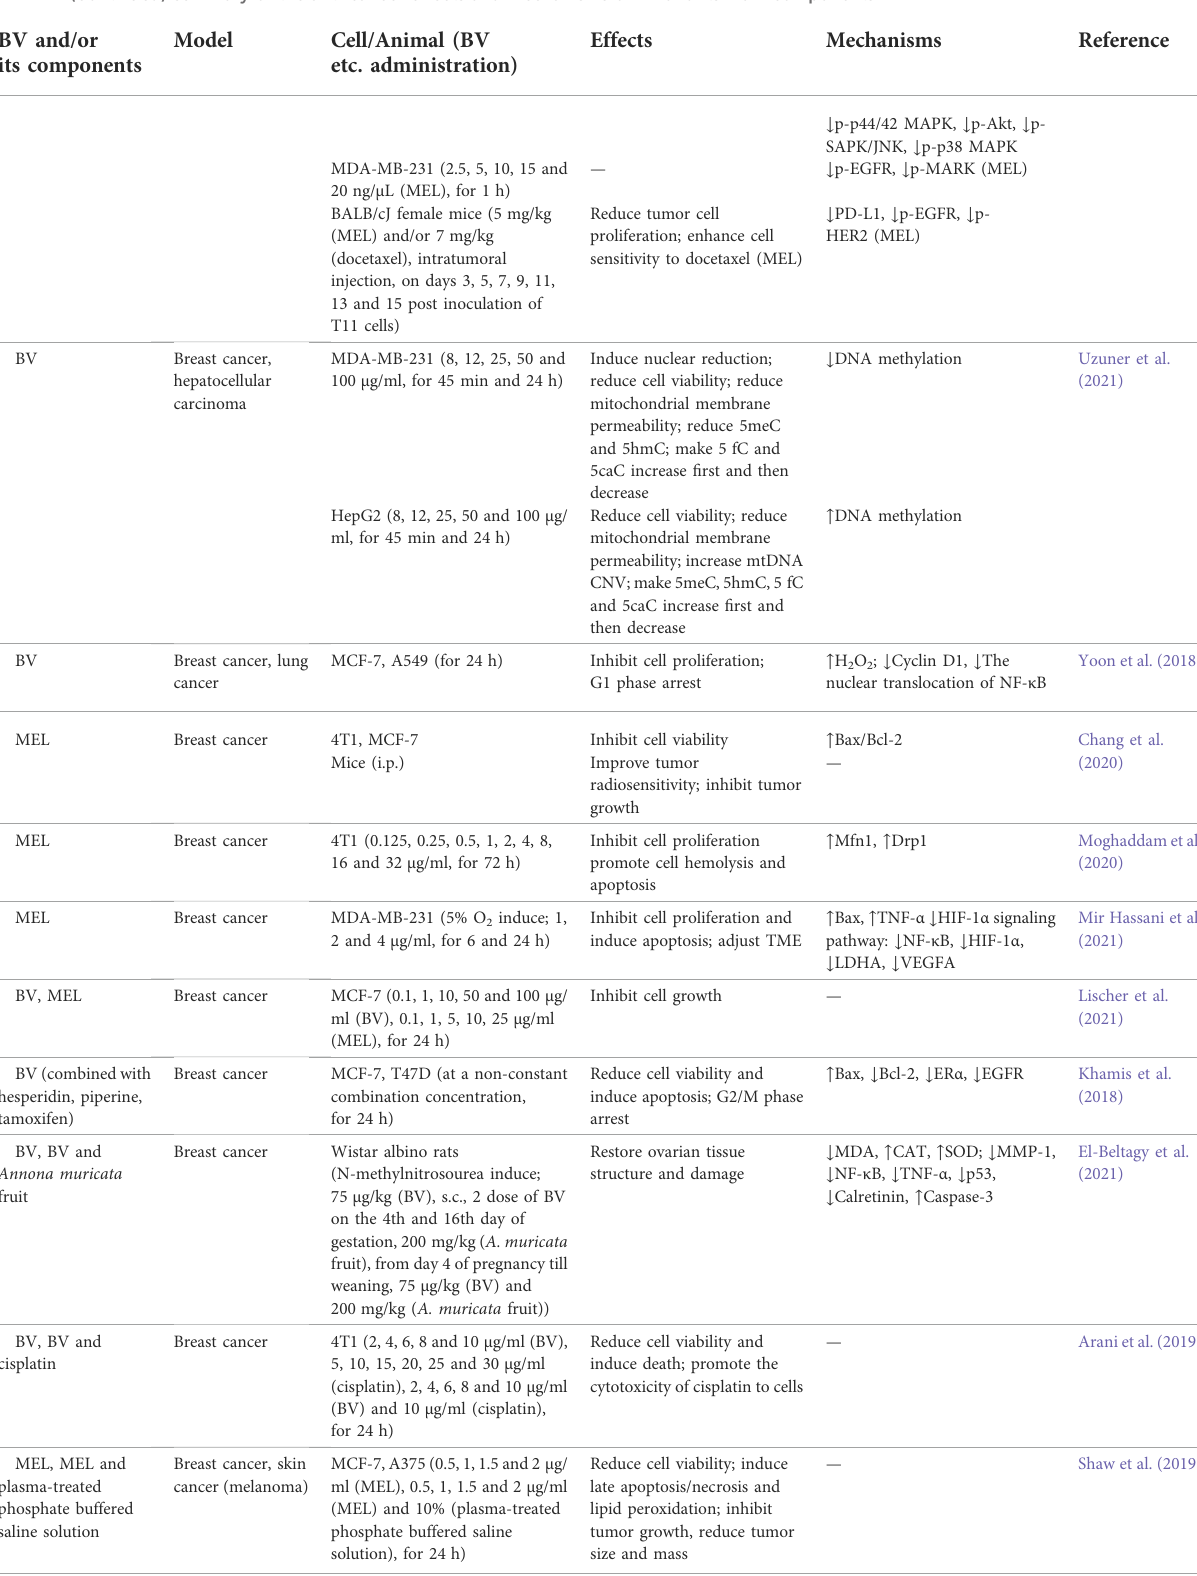
TABLE 1 ( Continued ) Summary of the anti-cancer effects and mechanisms of BV and its main